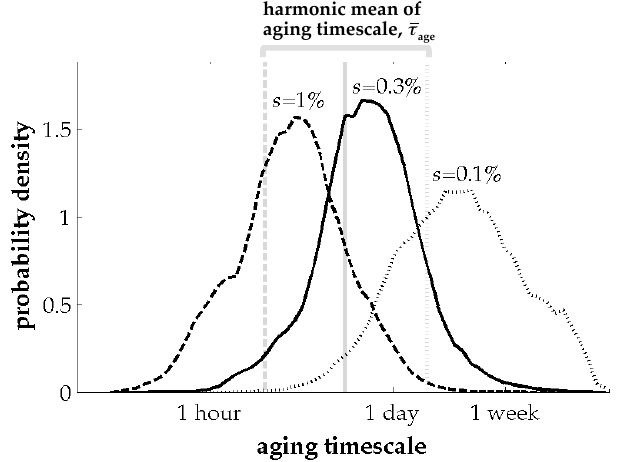
Figure 5. Probability density function of aging timescales for the full ensemble of sensitivity simulations, computed at three environ- mental supersaturation levels: s = 0 . 1%, s = 0 . 3%, and s = 1%. millions of individual particles in the training set. Values for Y age ,i (t,t + (cid:49)t,s) in the training set are weighted according to the kernel function K h (x − x i ) , where x is the independent variable of interest. The expected value of Y age (t,t +